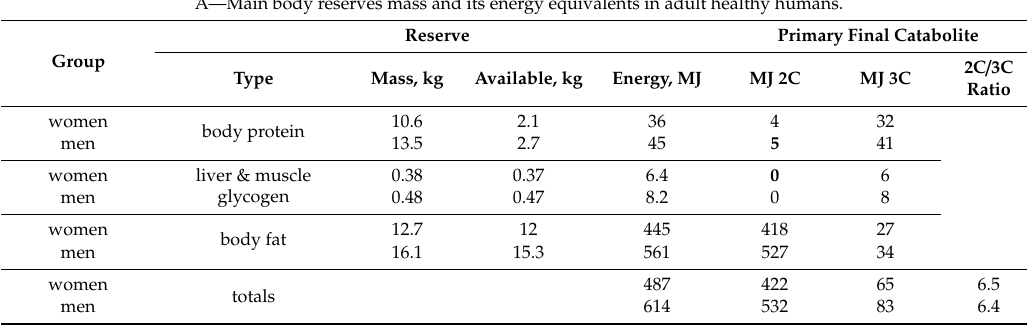
Table 1. Mass of energy reserves in the human